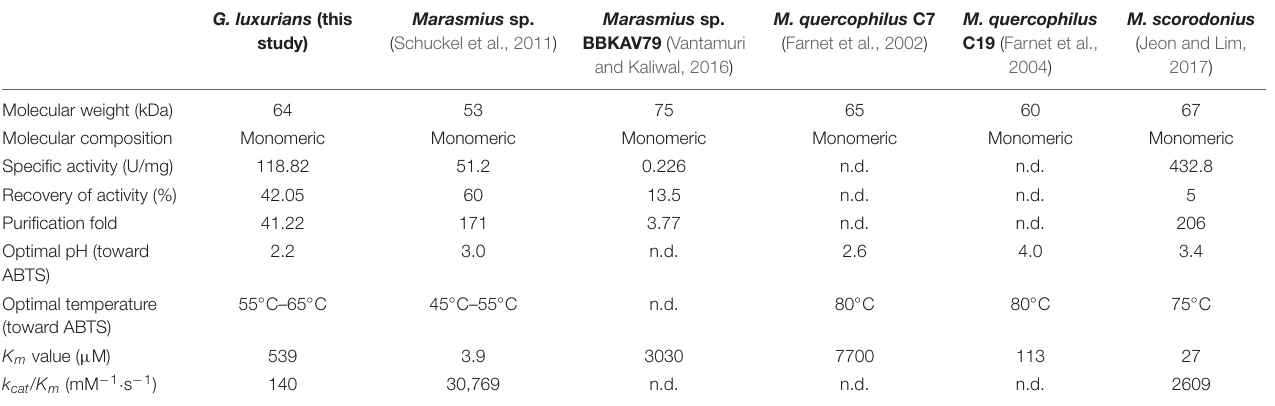
TABLE 3 | Characteristic comparison of GLL from G. luxurians strain YAASM5159 (this study) and other laccases from family Marasmiaceae. G. luxurians (this